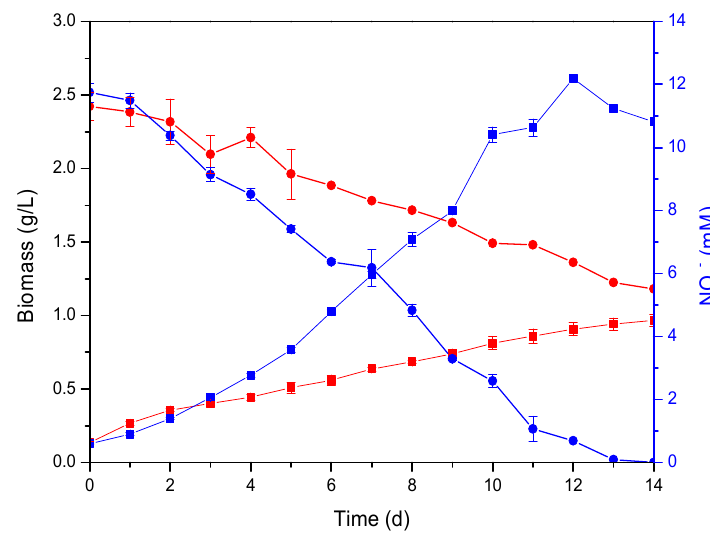
Figure 4. Growth curves (squares) and nitrogen uptake (circles) for cultures of P. tricornutum under an 18:6-h photoperiod with continuous CO 2 injections in photobioreactors at different scales: 1-L bottle (blue symbols) and 90-L column bioreactor (red symbols). Table 7. Biomass analysis for the 1 L bottle culture and the 90 L scale.